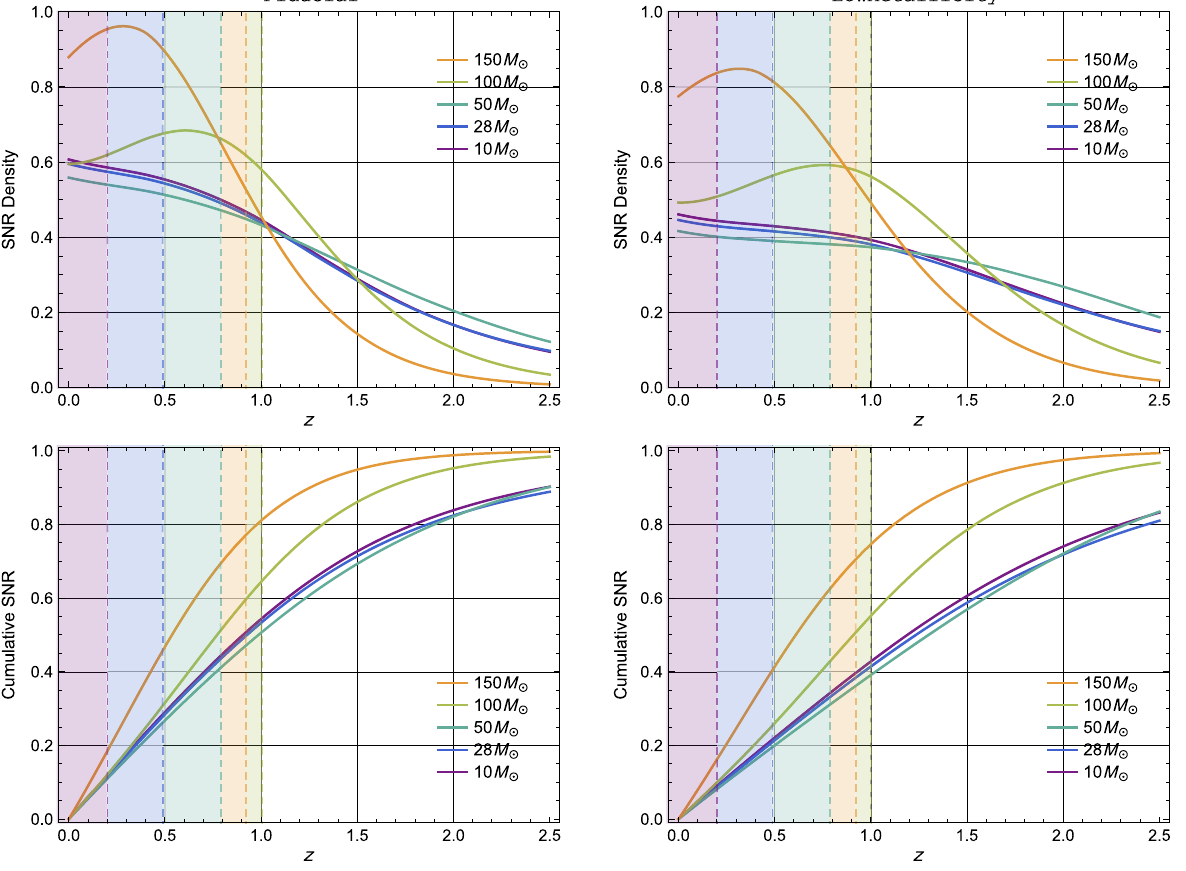
FIG. 2. Top: SNR density d ð SNR Þ =dz for various choices of chirp mass, assuming the Fiducial (left) and LowMetallicity (right) background models. Each curve is normalized such that its integral over all redshifts is 1. Bottom: Cumulative SNR, found by integrating SNR density from ð 0 ; z Þ assuming the Fiducial (left) and LowMetallicity (right) models. For each choice of mass, the total SNR is normalized to 1. The dashed vertical lines indicate Advanced LIGO ’ s “ threshold redshifts ” z 50% for binaries of each chirp mass (given by the respective color). More than 50% of binaries merging at z < z 50% (in the shaded regions) will be individually resolvable. Most binaries at z > z 50% cannot be individually resolved, but contribute to the measured stochastic signal. Note that, because much of the signal from high-redshift M c ¼ 150 M ⊙ binaries is redshifted out of Advanced LIGO ’ s sensitivity band, z 50% for such binaries is lower than for those with M c ¼ 100 M ⊙